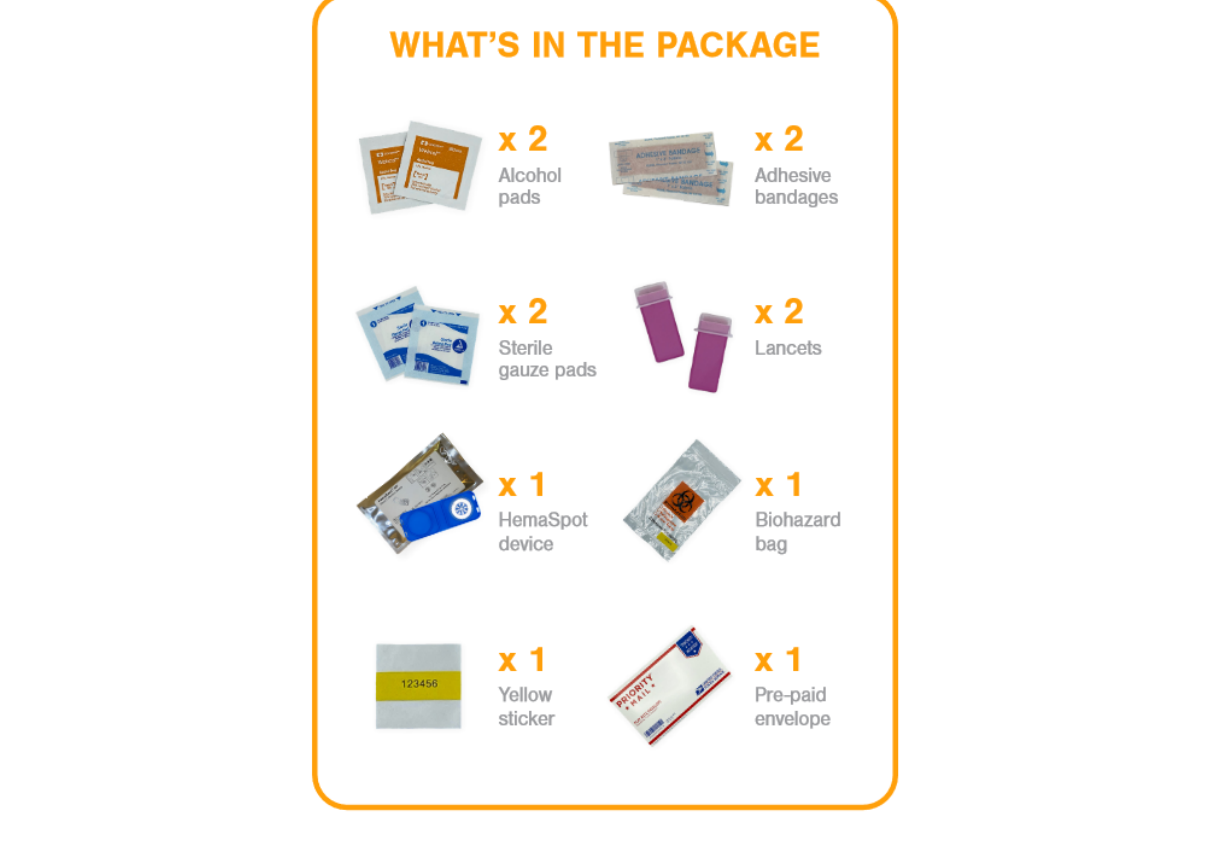
Figure 12. Two HemaSpot-HF blood collection devices (open and